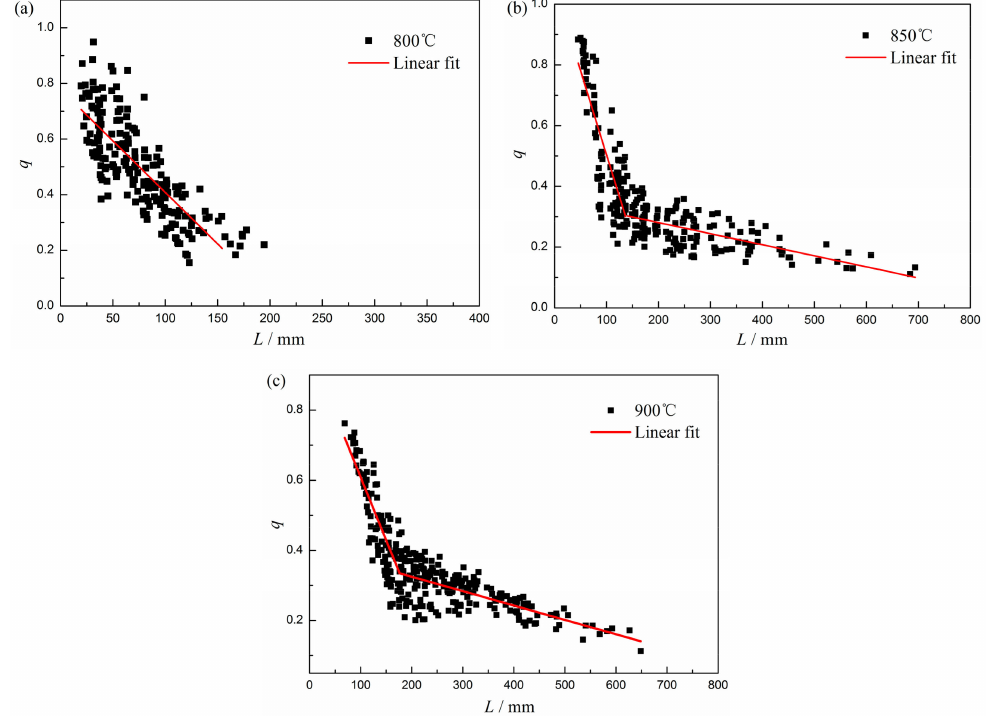
Figure 7. Variation in the aspect ratio q ( q = e / L , where e is the thickness of the disc-shaped particle) versus the radius of disc-shaped particle L in GH4169 after isothermal aging at ( a ) 800 ◦ C; ( b ) 850 ◦ C; and ( c ) 900 ◦